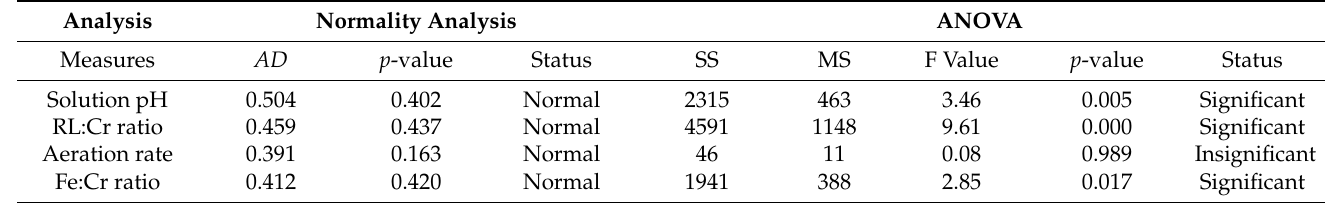
Figure 7. Normal probability plots of chromium removal versus ( a ) solution pH, ( b ) RL/Cr ratio, ( c ) aeration rate and ( d ) Fe/Cr ratio. Table 3. Results of normality test and analysis of variance of chromium removal against operating